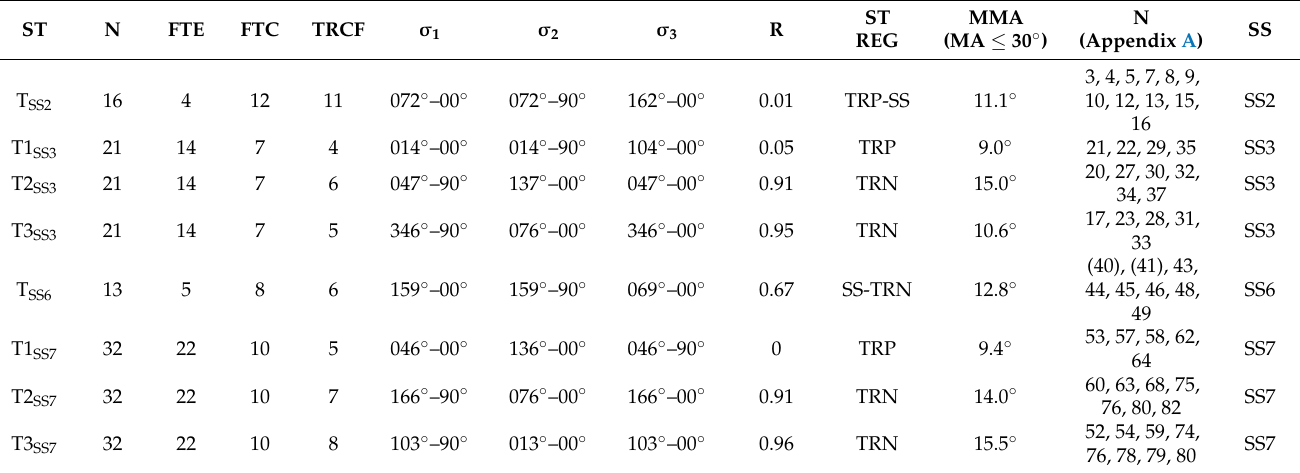
Table 2. The enhanced Andersonian site stress tensors (MA ≤ 30 ◦ ) with the TRM application